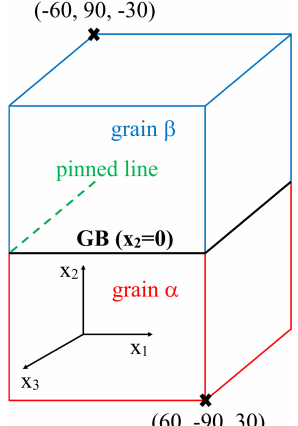
Figure 2. Sketch of the two rectangular grains of dimensions 120 × 90 × 60 used for the FE simulations.